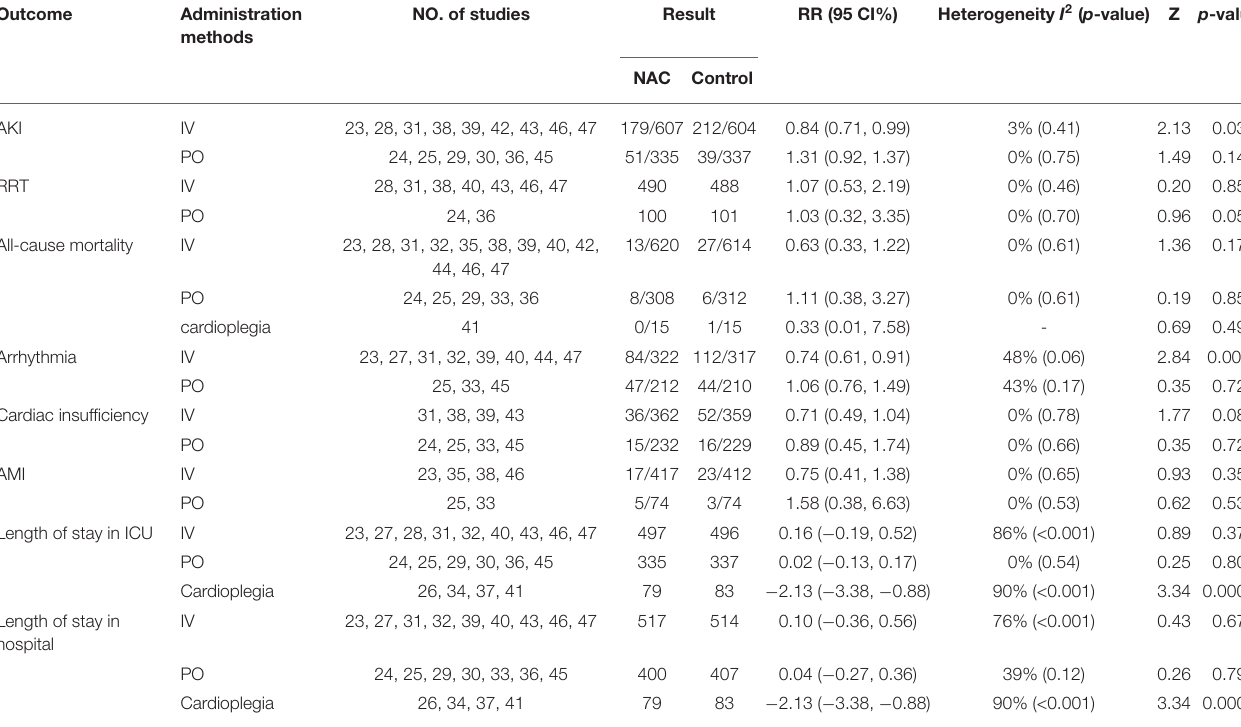
TABLE 2 | Effect of NAC administration methods on outcomes.